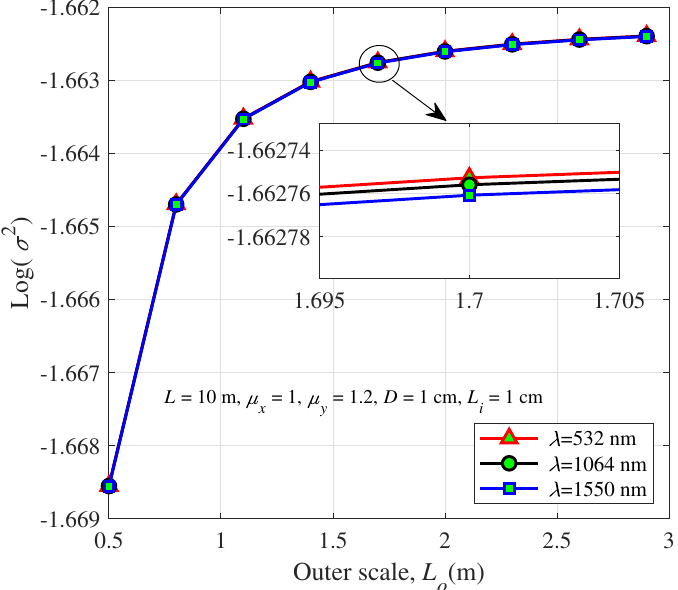
Figure 3. Scintillation index of a spherical wave versus the outer scale for different